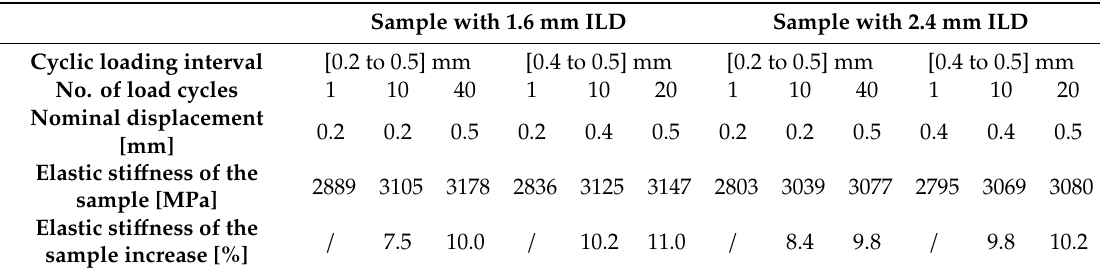
Table 4. Summary of the elastic sti ff ness (ES) of the sample changes induced by cyclic compressive